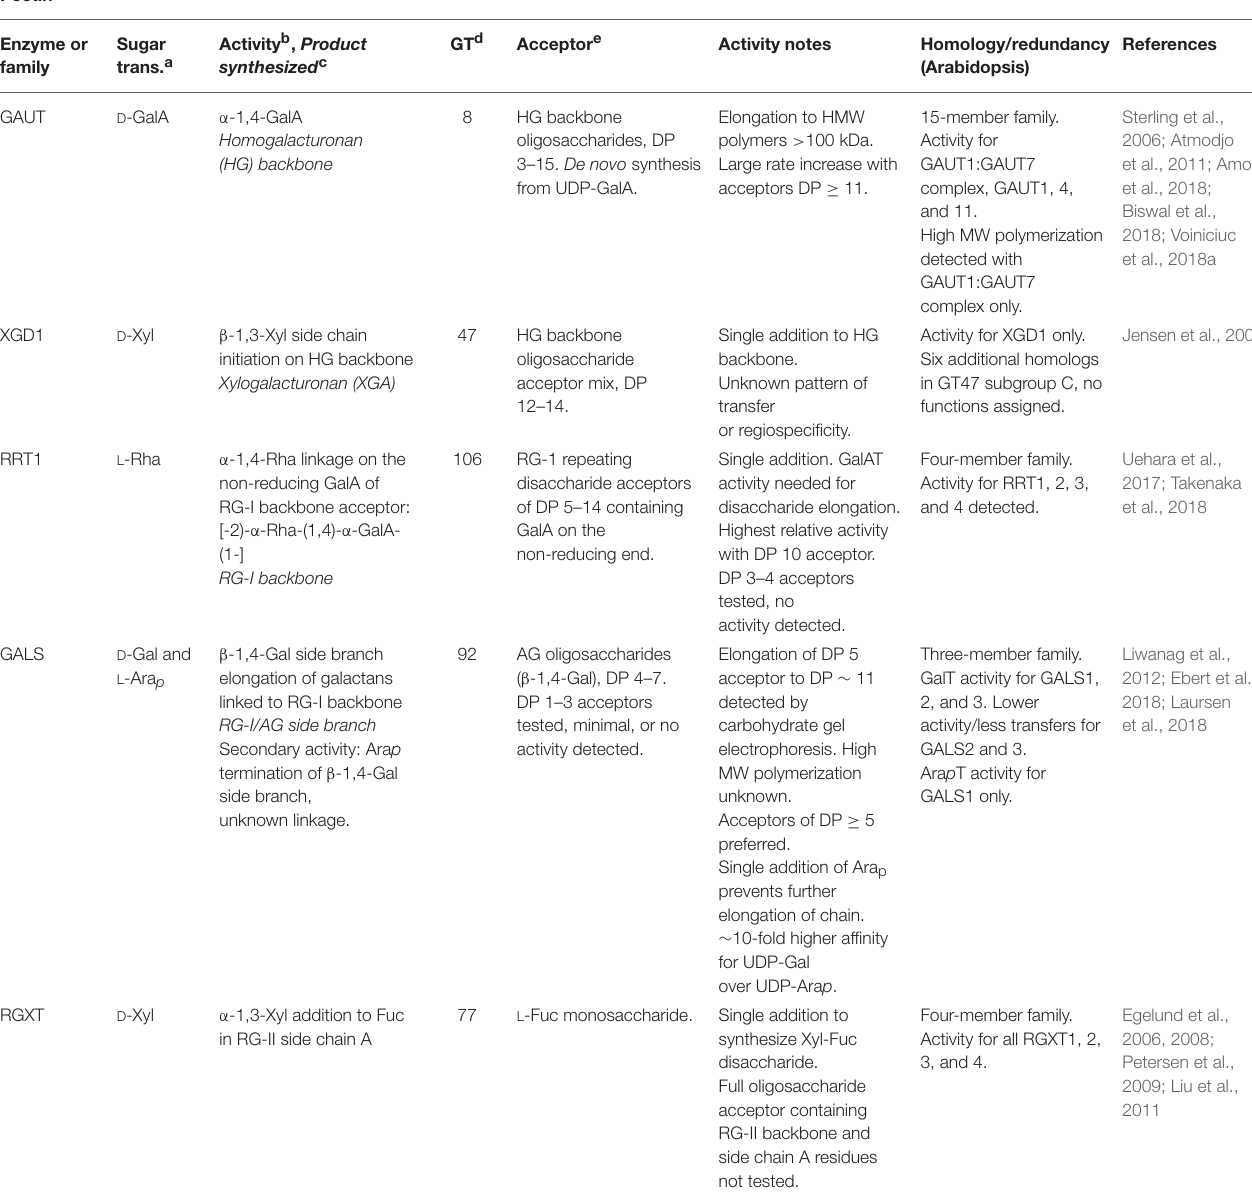
TABLE 5 | Pectin biosynthetic GTs of known function determined by heterologous expression.